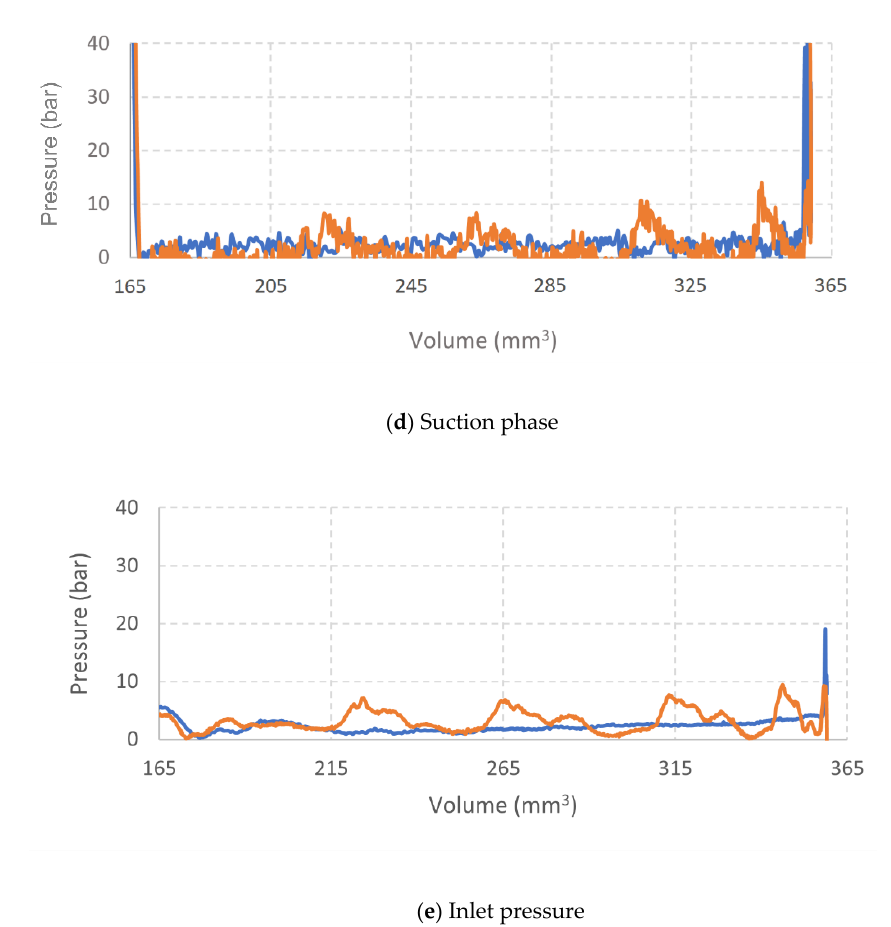
Figure 10. PWC and inlet diagrams for 1500 and 3000 RPM, HP, D100.